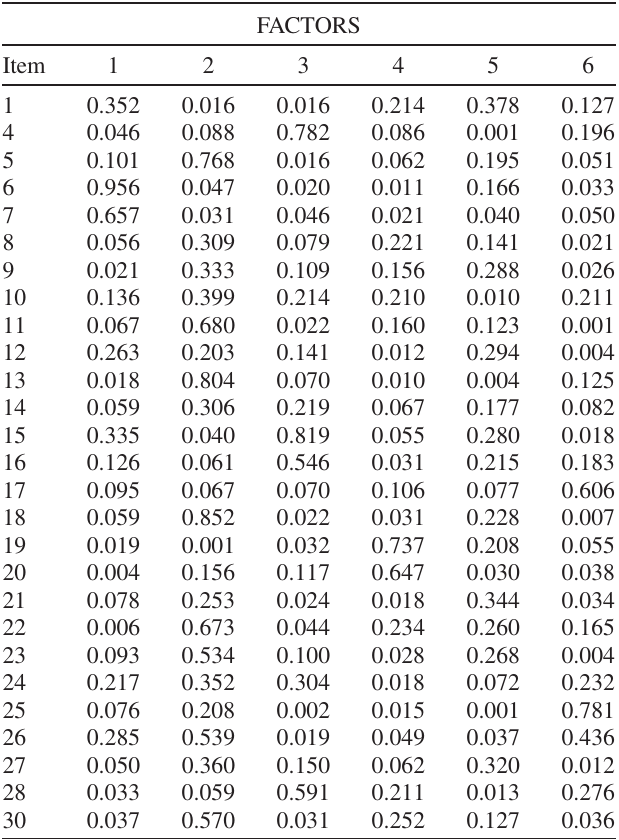
TABLE IV. The factor model results are shown for the FCI post-test analysis using M plus with WLSMV estimation on tetrachoric correlations. A QUARTIMIN rotation was ef- fected. Here the absolute values of all of the loadings are shown. The italicized values are those below the threshold of